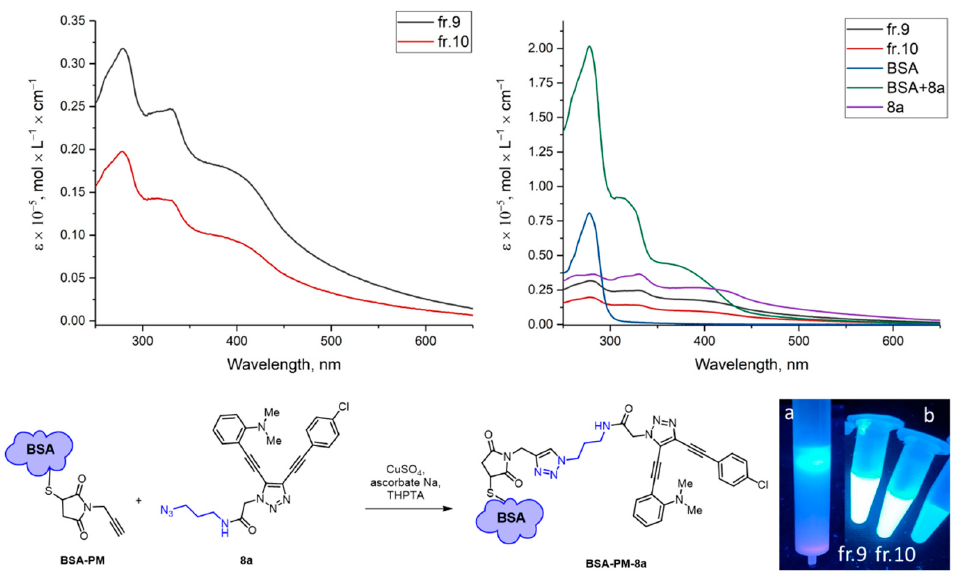
Figure 8. Absorption spectra of labeled BSA fractions (left) and pure spectra for reference (right); labeled BSA running front ( a ); labeled BSA collected fractions ( b ).